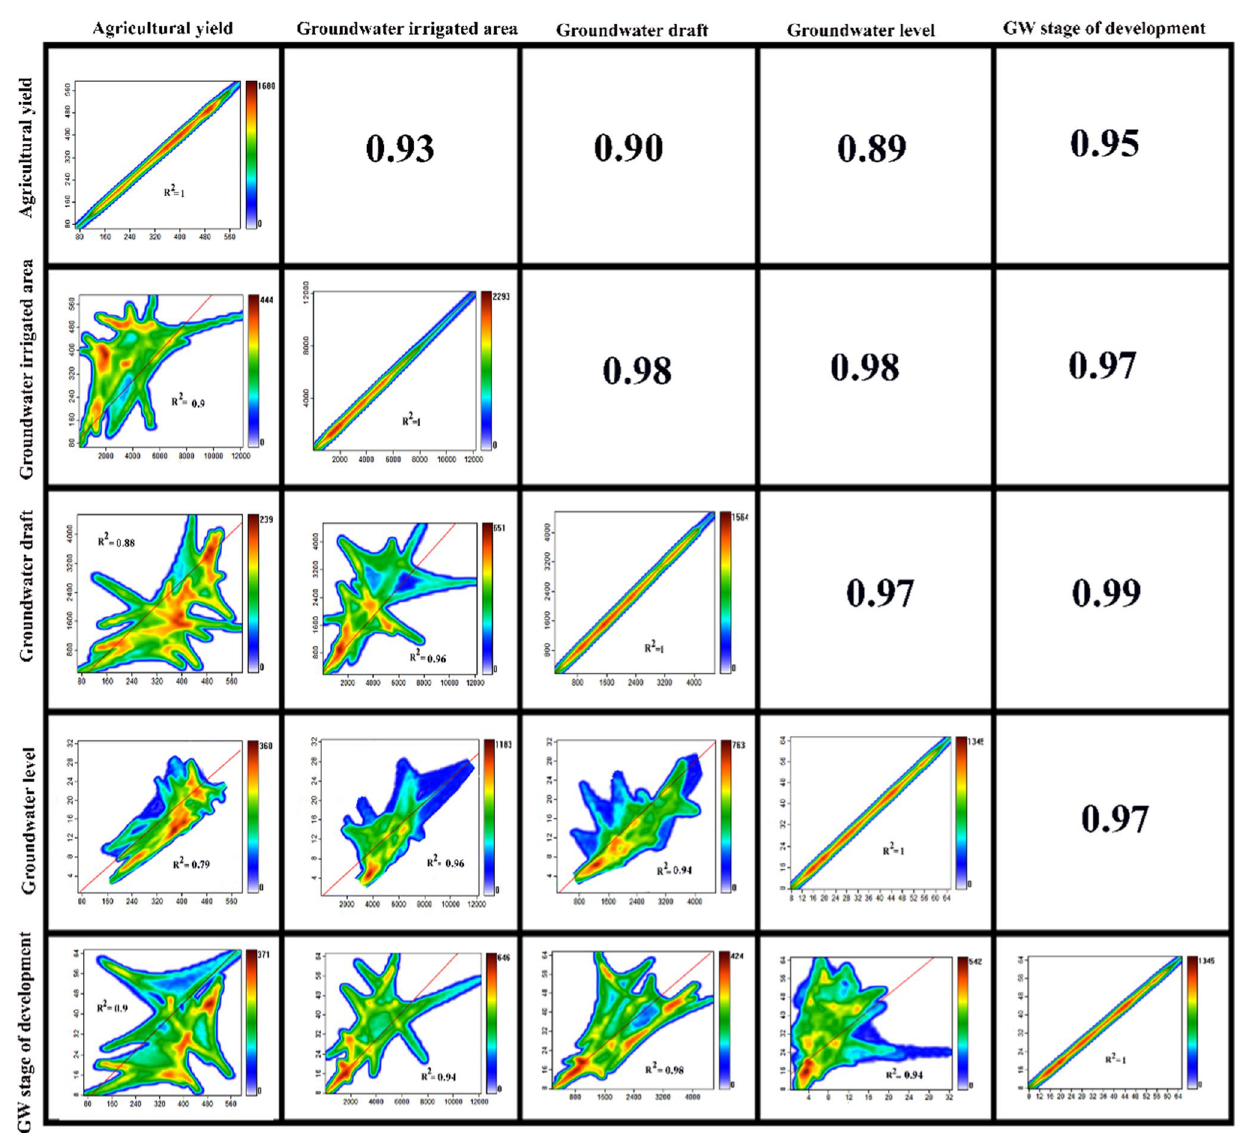
Fig. 17 Relational matrix between concerning